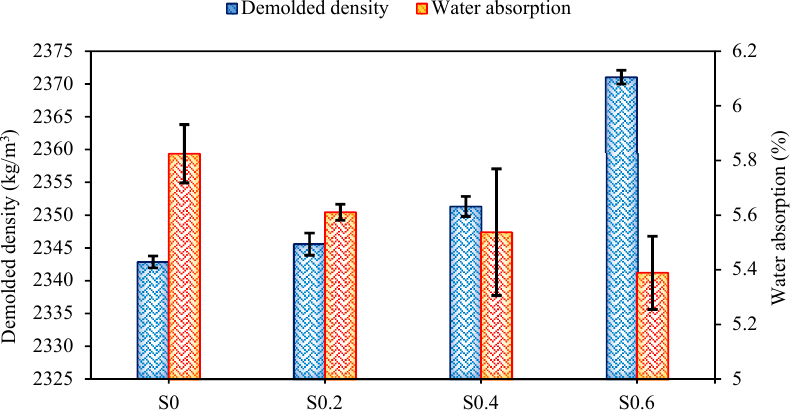
Figure 4. Demolded density and water absorption of the FR-AASCs. The density of the control mix (plain) was calculated at 2343 kg/m 3 . With the incorpo- ration of 0.2%, 0.4%, and 0.6% RTSF by volume fraction in the AASC mixture, the density increased to 2346, 2351, and 2371 kg/m 3 , respectively. The increase in demolded density can be ascribed to the higher specific density of RTSF compared to the AASC matrix [75,76]. As can be seen in Figure 4, when the volume fraction of RTSF increased from 0% to 0.6%, the water absorption slightly diminished from 5.65% to 5.25%. This reduction could be explained by the random distribution of short fibers, which prevented the devel- opment of the micro-cracks by stitching them [77,78] and reducing the number of voids by the occupation of pores [79].